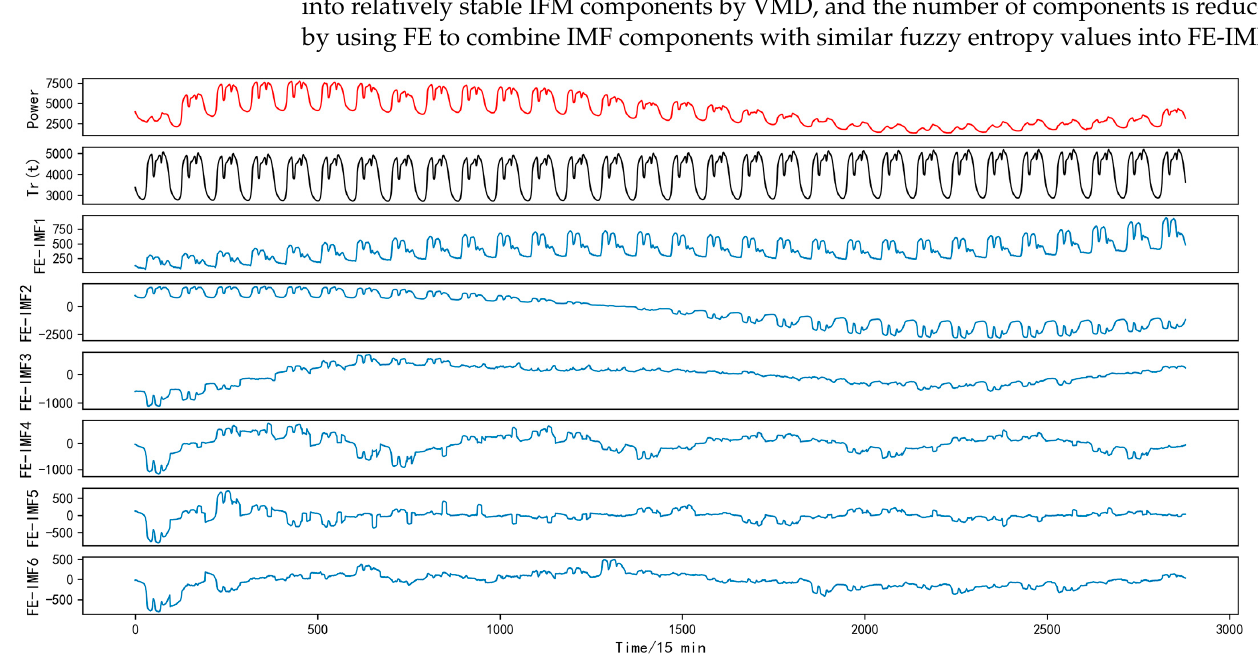
Figure 15. FE reorganization results for Area 1.